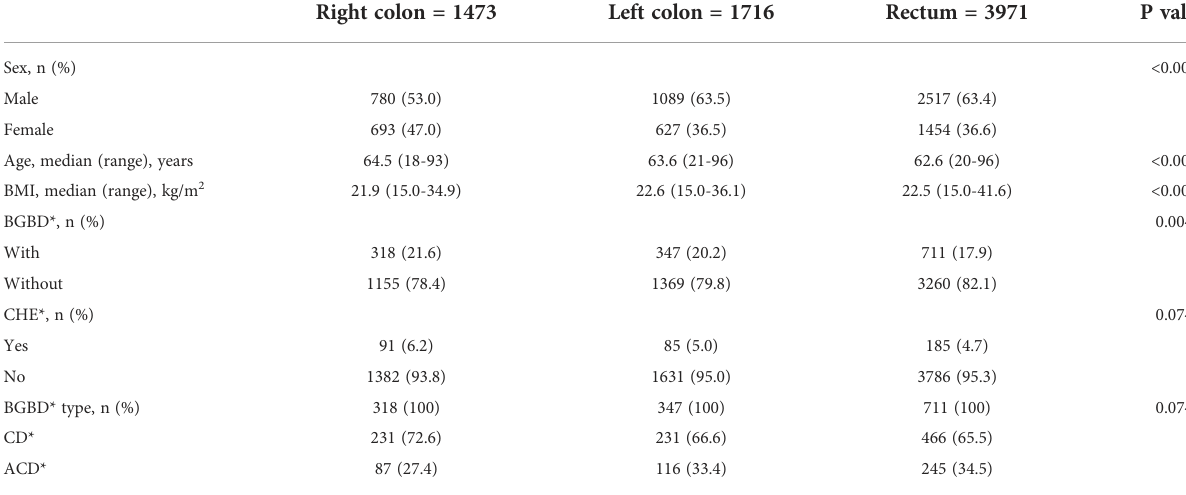
*BGBD, benign gallbladder disease. CHE, cholecystectomy. CD, calculous disease. ACD, acalculous